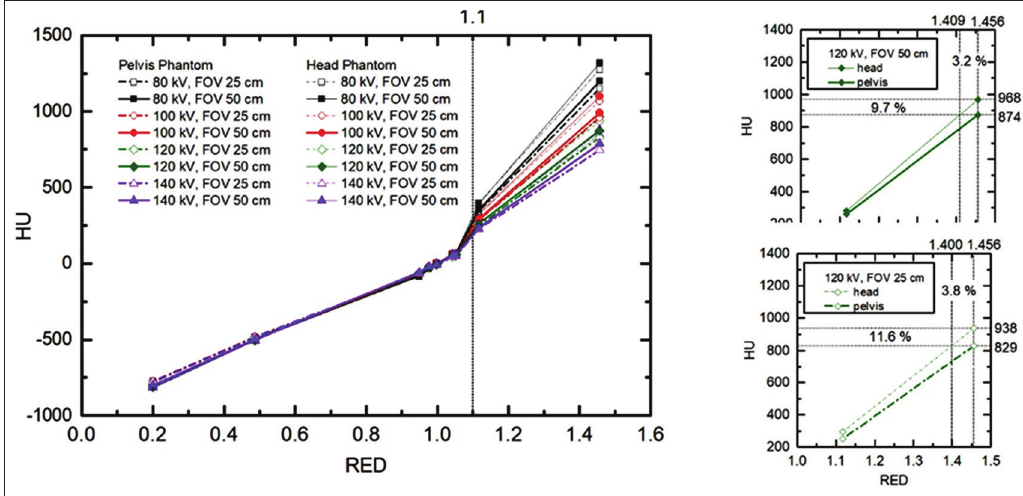
FIGURE 6. Change of the Hounsfield units depending on the relative electron density at different values of computed tomo graphy tube potentials and field of view sizes for computerized imaging reference systems 062M pelvis and head